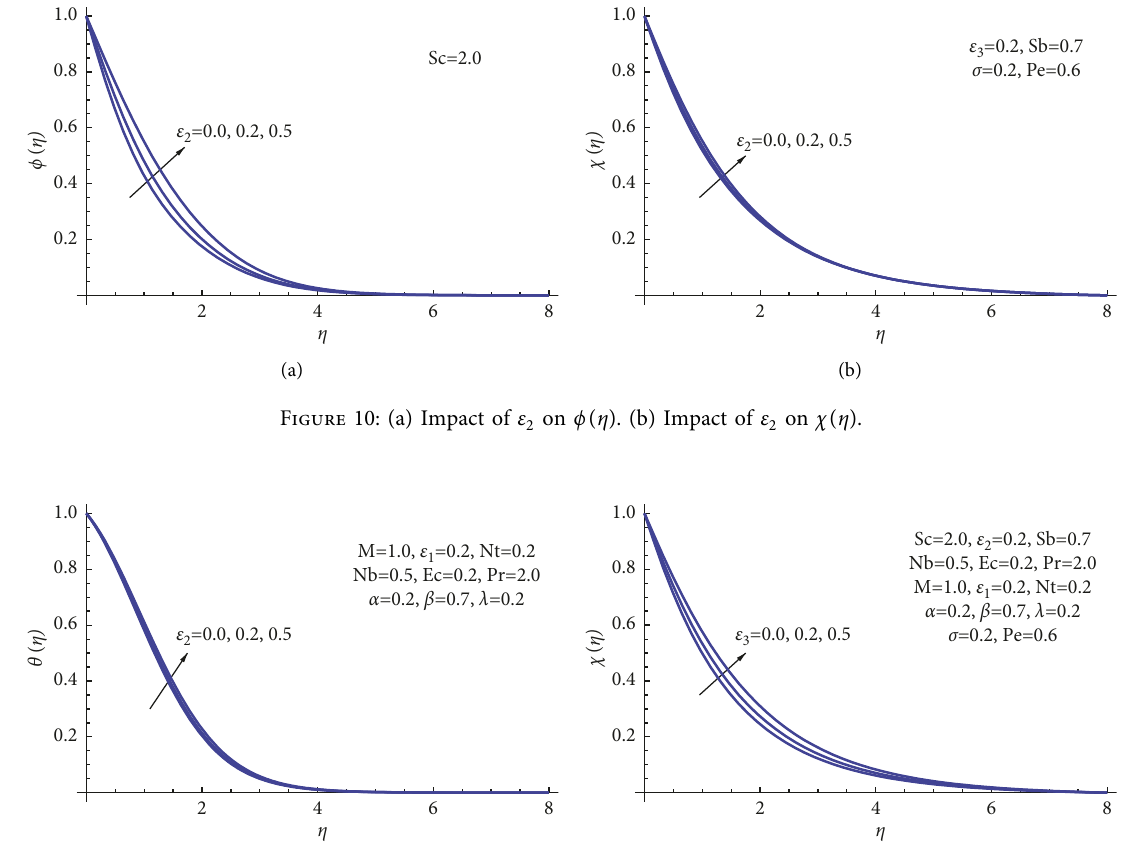
on θ ( η ) . (b) Impact of ε 2